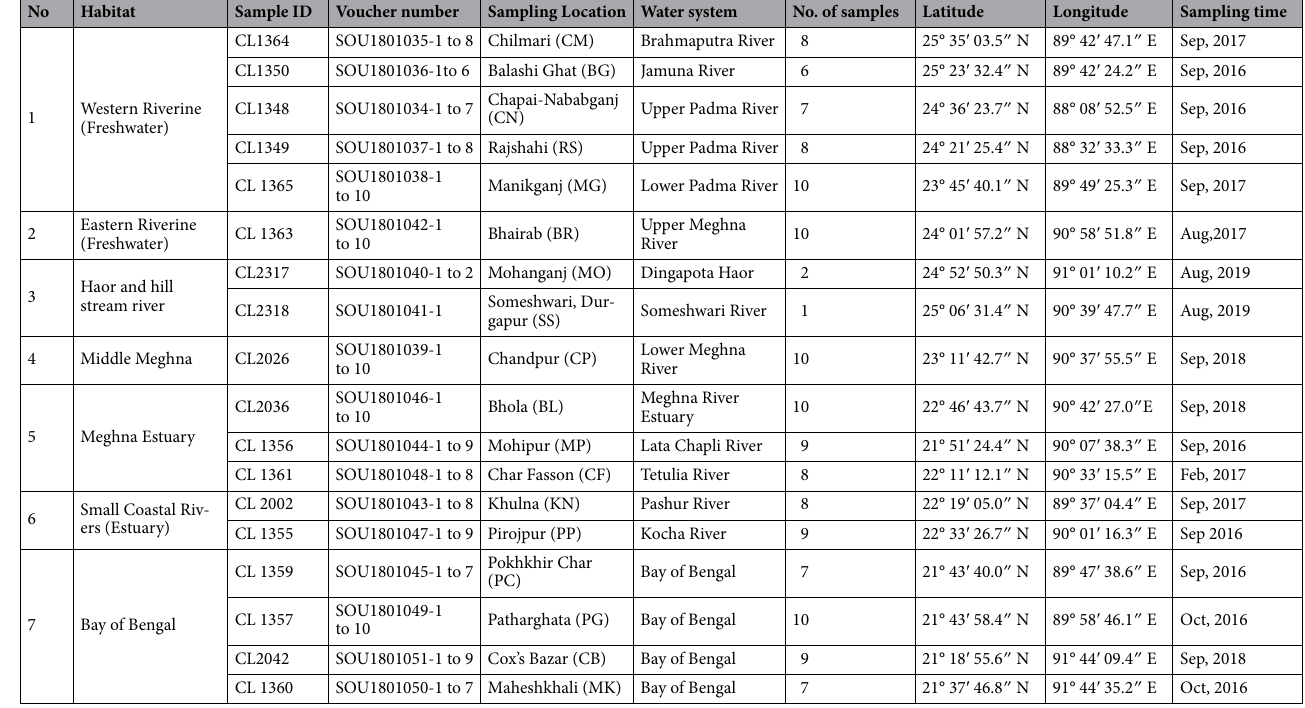
Table 1. Sampling localities, number of samples from each site and sampling